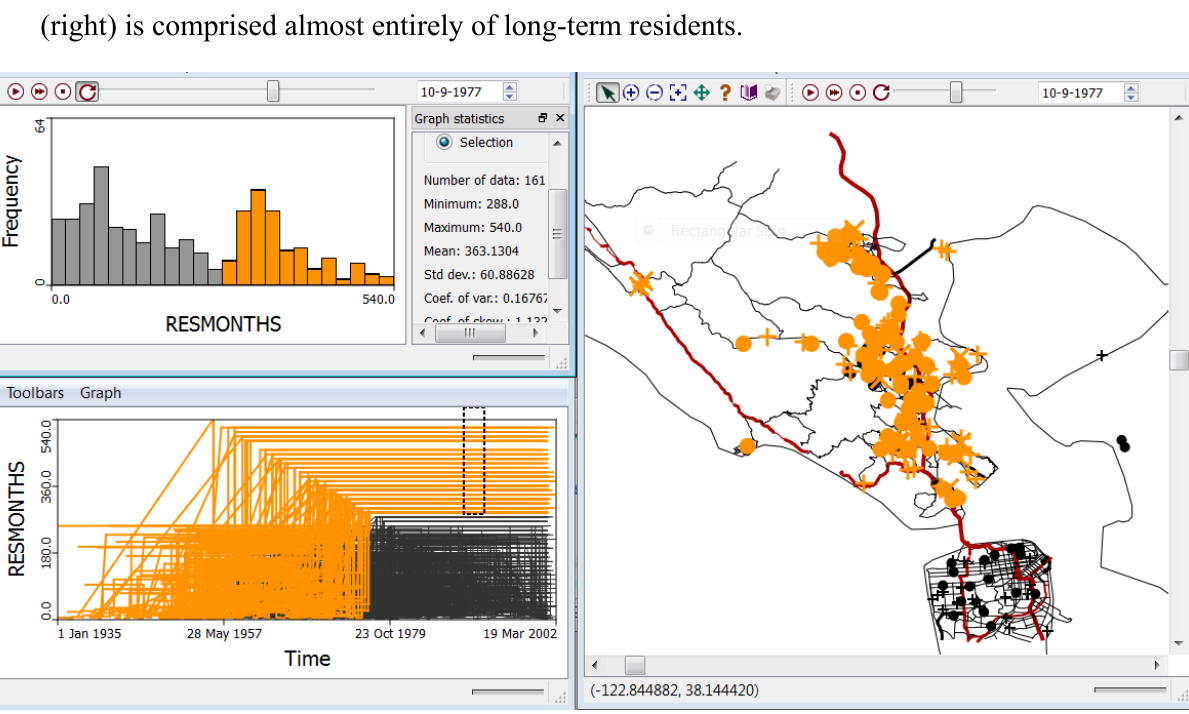
240 months (20 years), when the study was conducted. The map of Marin on